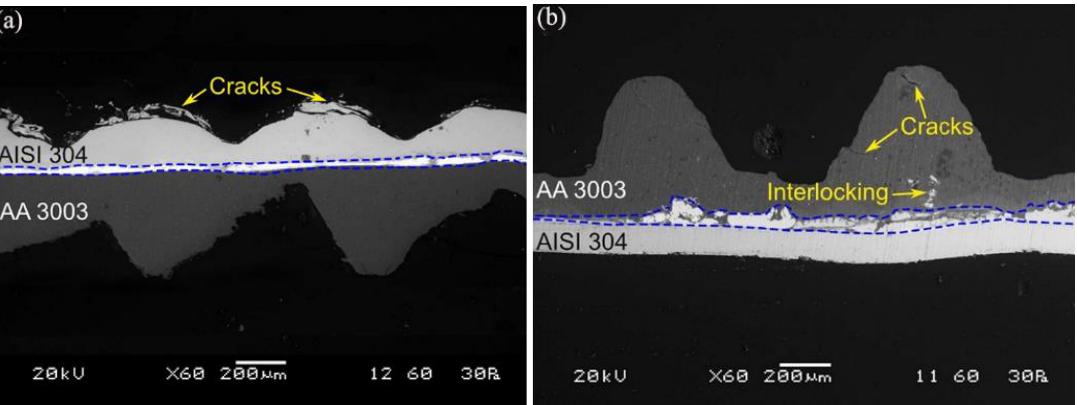
Figure 13. Micromorphology of the welding interface [22]: ( a ) AA 3003-Al-alloy-to-AISI-304-SS joint with Cu interlayer; ( b ) AISI-304-SS-to-AA-3003-Al-alloy joint with Cu interlayer.